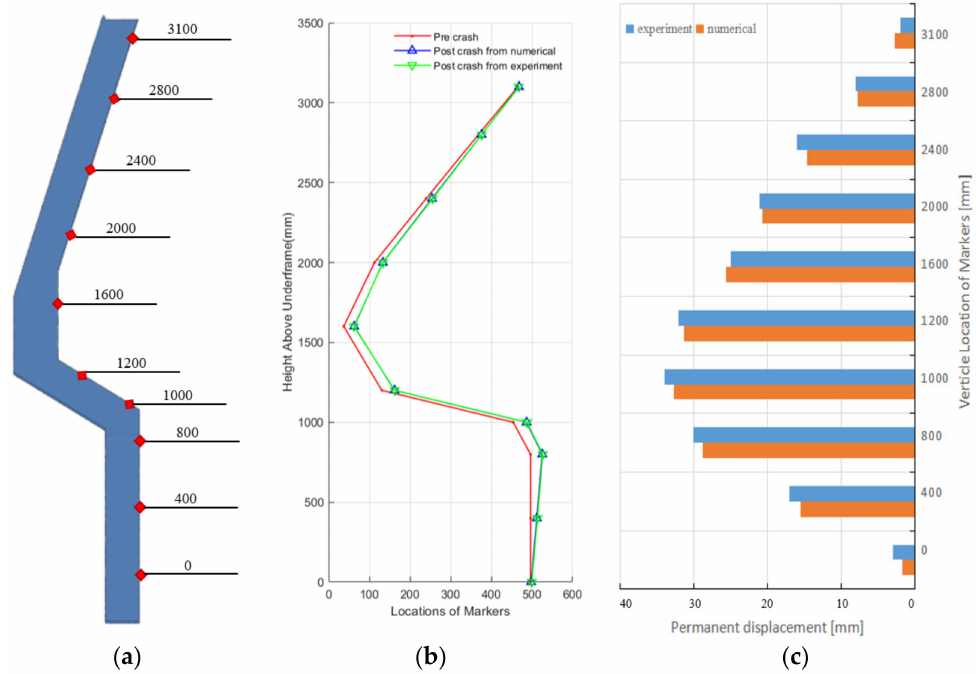
Figure 9. Longitudinal displacement comparison between the experiment and simulation: ( a ) permanent displacement along the collision post vertically; ( b ) permanent longitudinal dis- placement at the location of 10 markers. ( c ) detailed displacement comparison for every marker before and after crash.